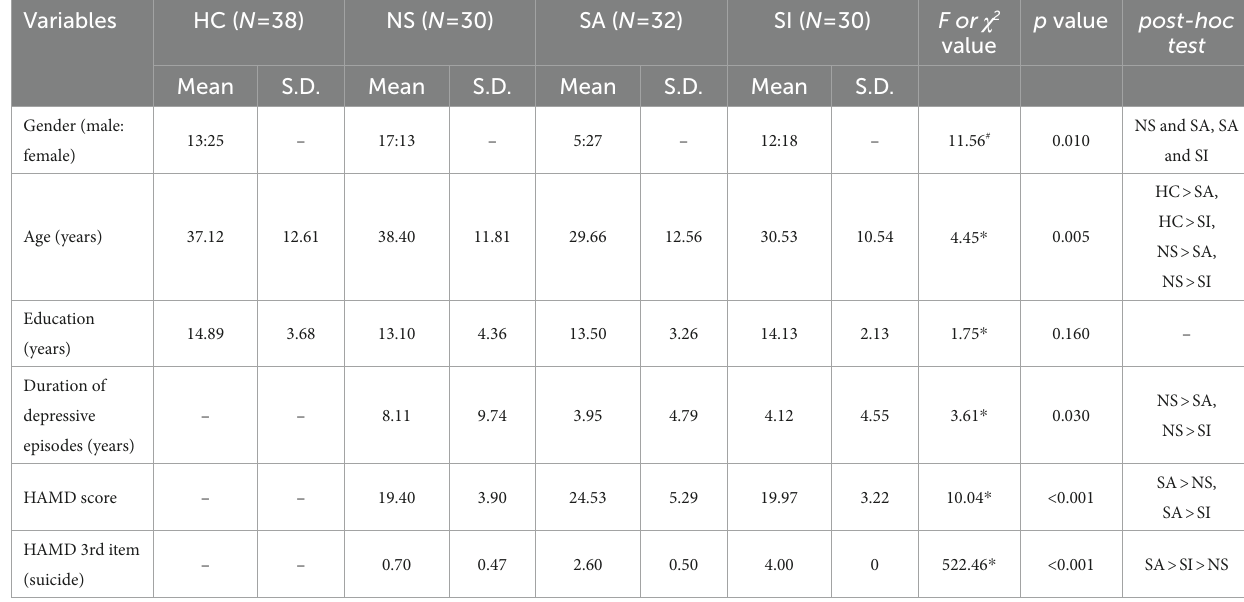
TABLE 1 Demographic characteristics of controls and MDD